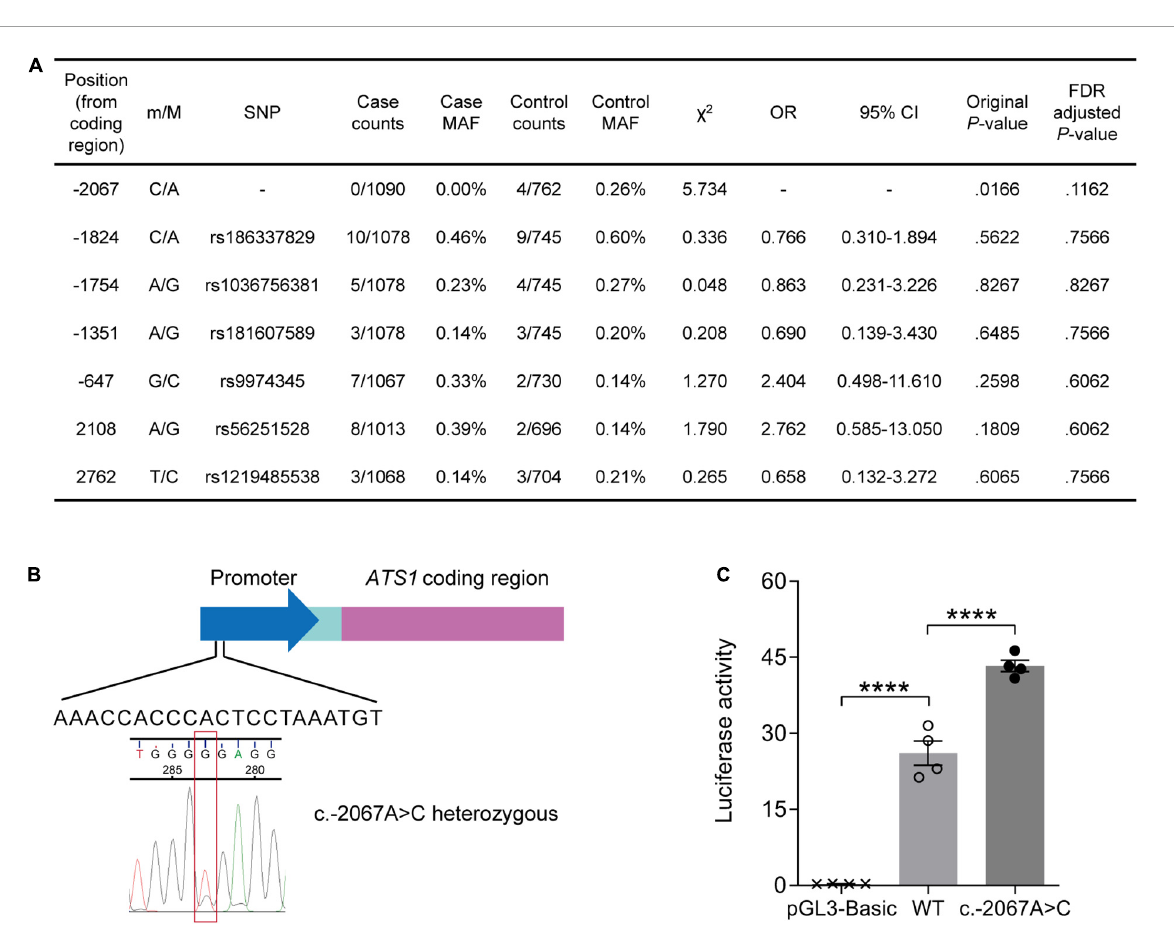
FIGURE1 A rare variant suggested by its weak association with lower AD risk stimulated ATS1 expression. (A) ATS1 re-sequencing was conducted using clinical samples from AD patients and healthy aged individuals. Statistical results of SNPs were shown. (B) A schematic diagram showing the position of SNP c.–2067A > C in ATS1 . (C) HEK 293T cells transfected with the ATS1 WT or c.–2067A > C promoter were subjected to dual-luciferase assay. The relative luciferase activity indicated that c.–2067A > C promoted ATS1 transcription compared with the WT promoter ( n = 4, P < 0.0001, c.–2067A > C vs. WT, one-way ANOVA). **** P < 0.0001. Data were expressed as Mean ± SEM. AD, Alzheimer’s disease; ATS1, ADAMTS1; CI, confidence interval; FDR, false discovery rate; MAF, minor allele frequency; OR, odds ratio; SNP, single nucleotide polymorphism; WT, wild